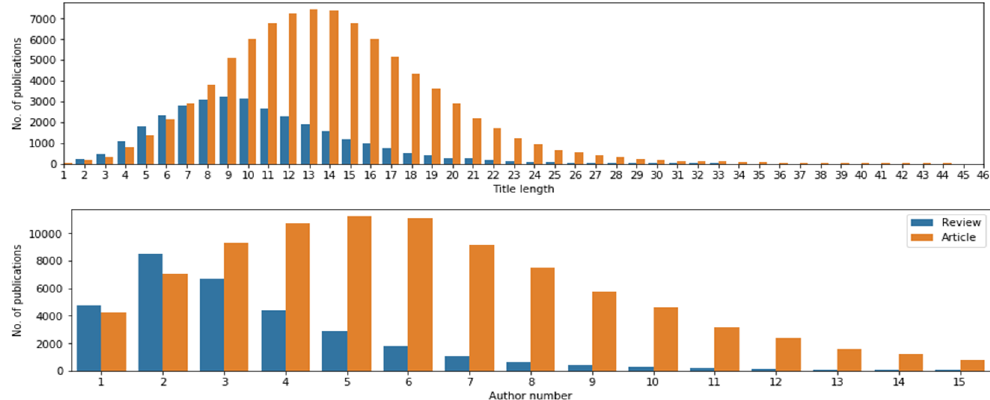
Figure A2. Above: distribution of title lengths in our dataset for review and articles. Below: distribution of author count. Blue bars indicate reviews and orange bars indicate articles. The length of the bar indicates the exact number of publications for that specific title length or author count in our dataset.